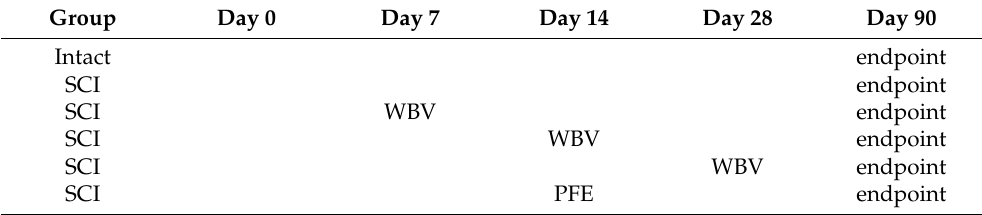
Table 1. Schematic representation of the timeline and the protocols